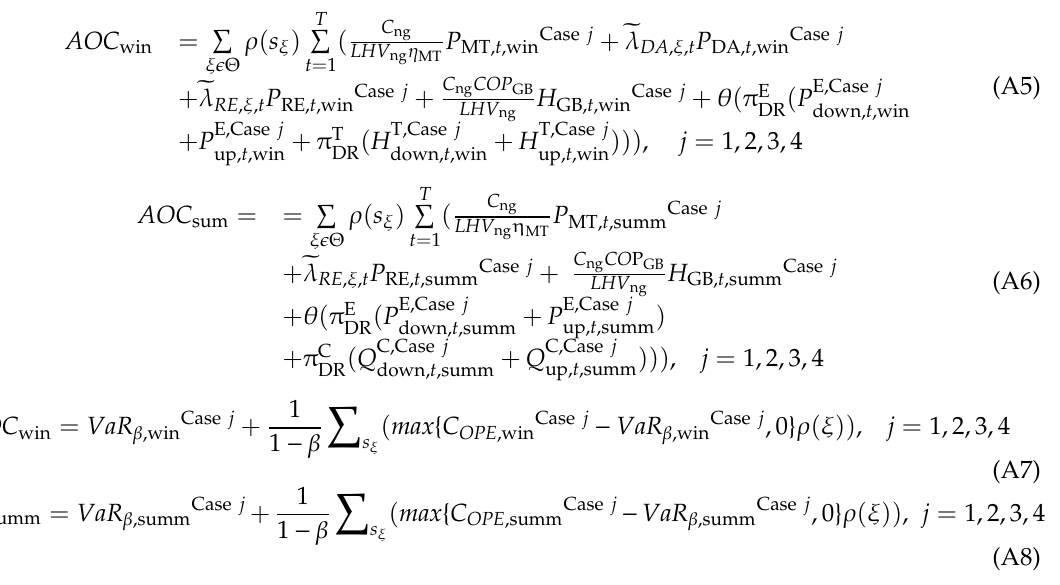
Figure A7. Electric/Cooling load curve for each period on the typical summer day.